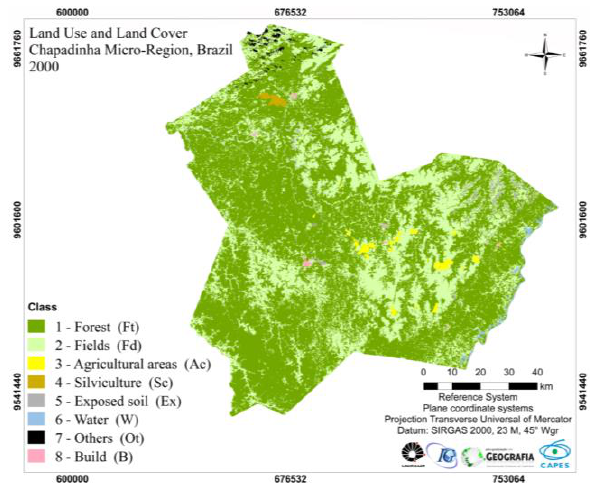
Figure 3. Land use and land cover map of the Chapadinha microregion (year: 2000).